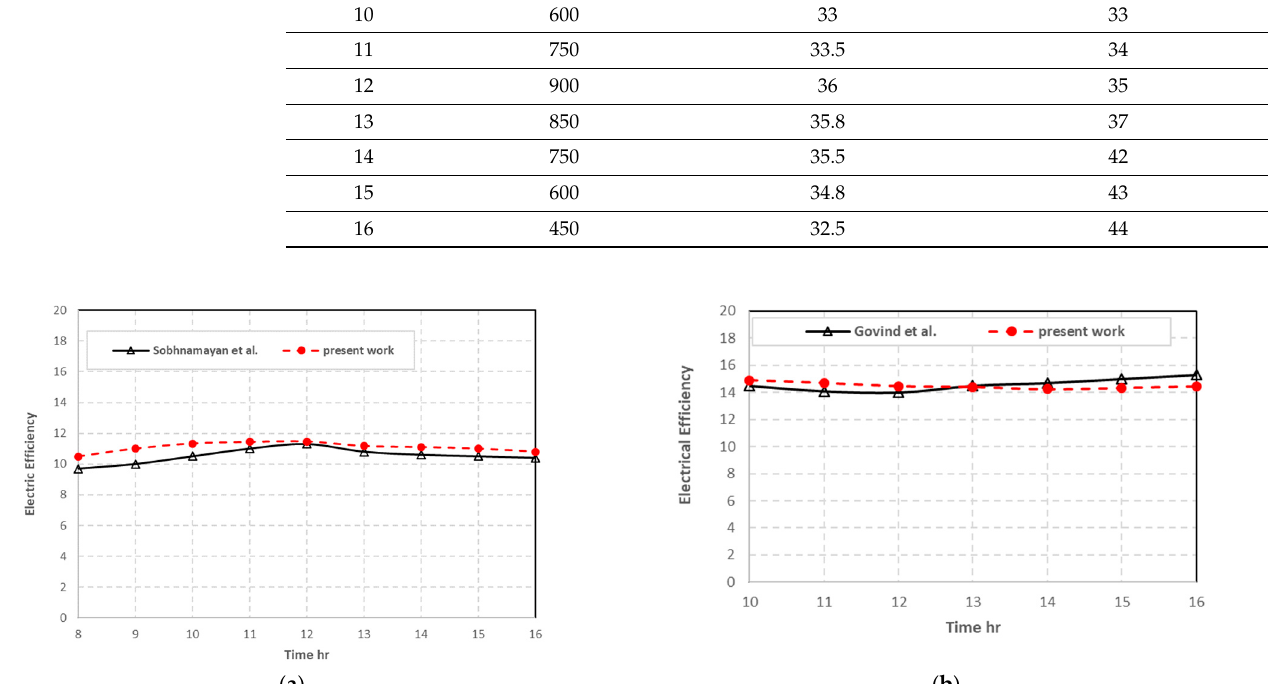
Figure 7. Hourly variations in efficiency of electrical energy ( a ) for present model and [40] ( b ) for present model and [41].